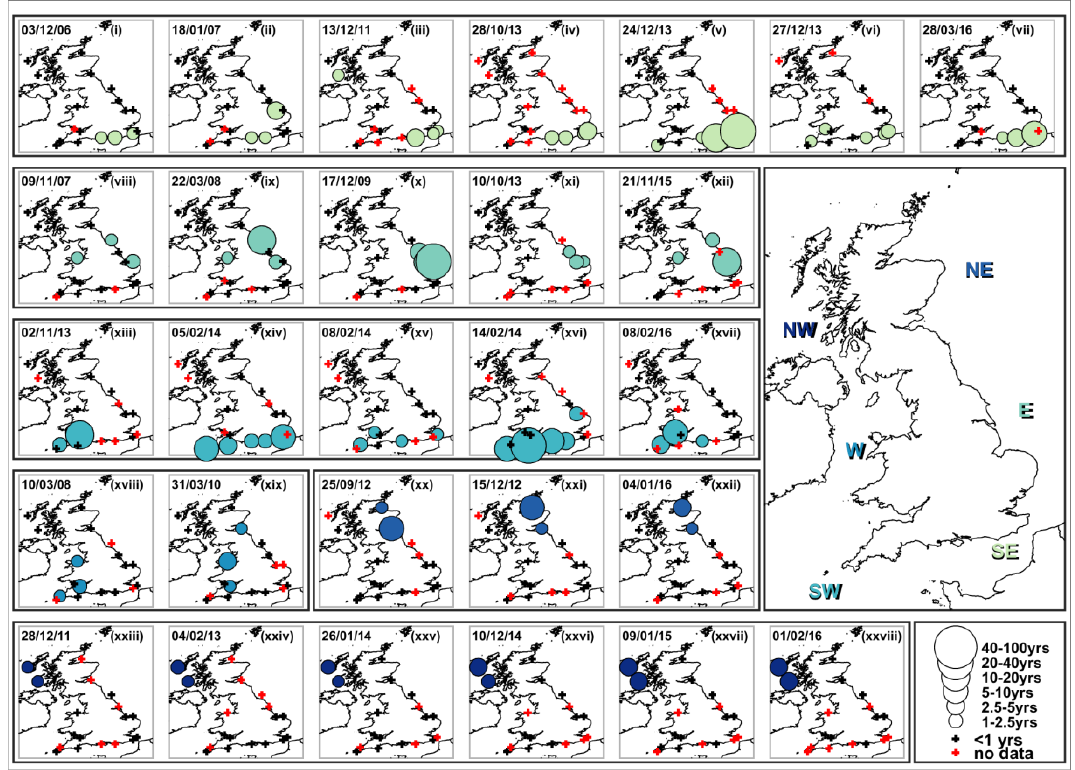
Figure 5. The spatial footprint of extreme events that affected three buoy sites (or two sites for the north of the UK). The events have been organized according to the regions they affected and subfigures have been sorted by date of occurrence within regions. The first number in the top left corner indicates the date on which they occurred and the Roman number in brackets is a label for each subfigure.